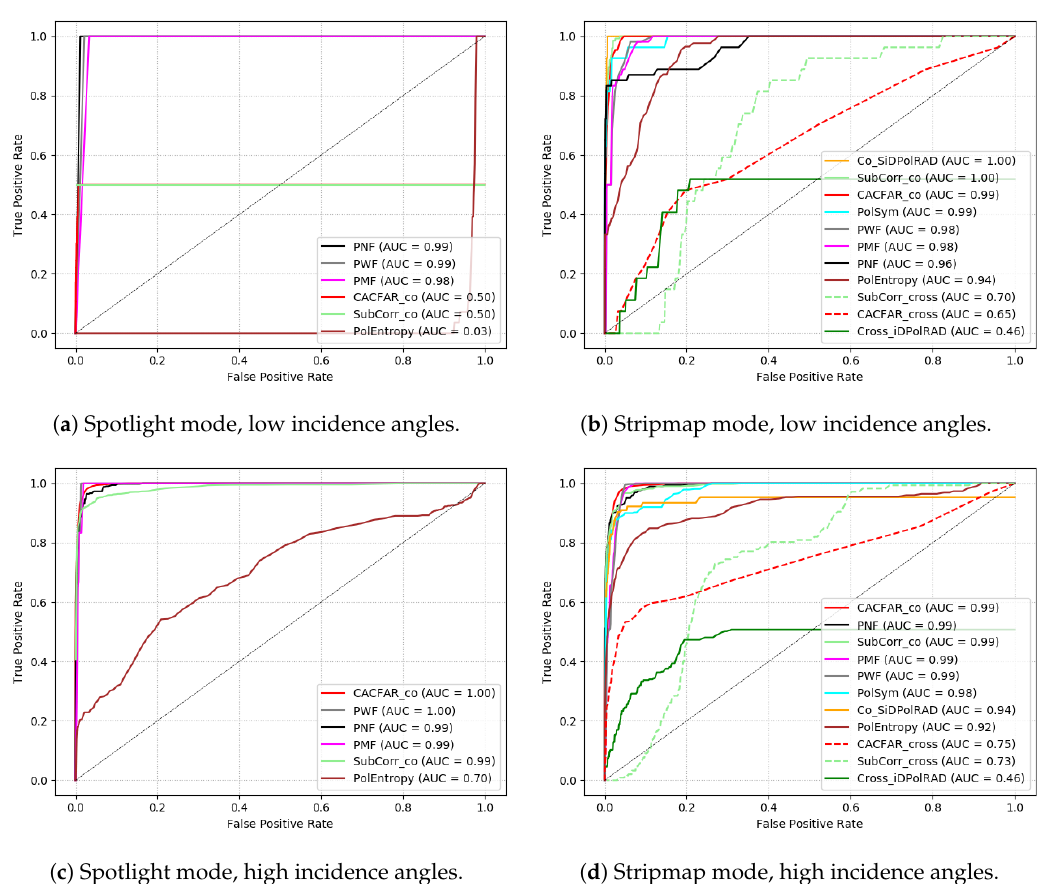
Figure 11. Impact of the incidence angle on the ROC curves for different acquisition modes (pixel-based, multilooked). Lower incidence angles decrease the AUC when cross-pol data is used (Figure